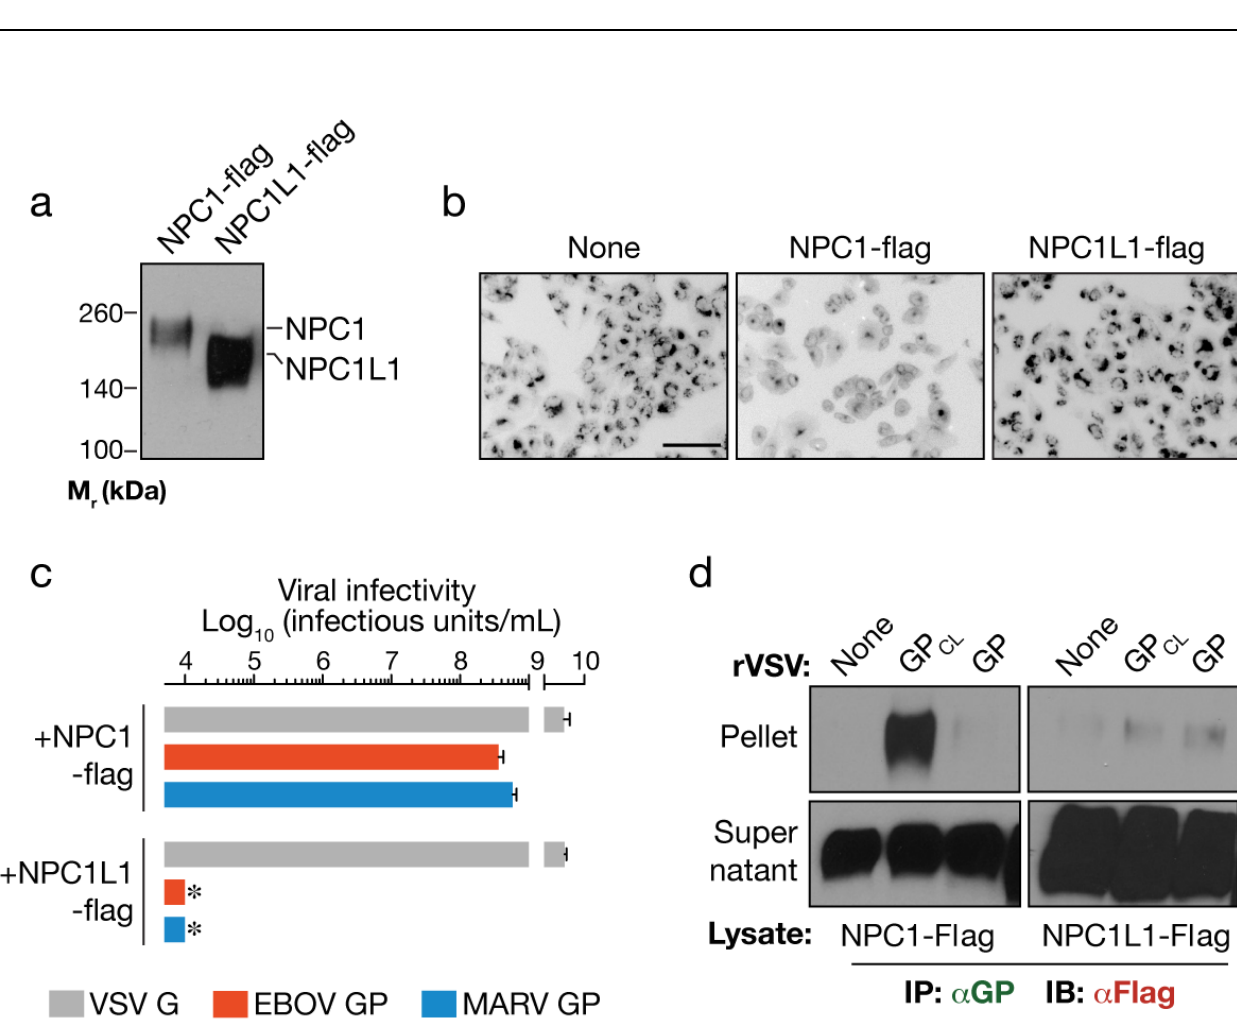
Figure 1. Human Niemann-Pick C1-like1 (NPC1L1) lacks filovirus receptor activity. (a) NPC1-null Chinese hamster ovary (CHO) CT43 cells were engineered to express human NPC1-flag or NPC1L1-flag. Protein expression was detected by immunoblotting with an anti-flag antibody. M , relative molecular weight in kilodaltons (kDa). (b) Efflux of r lysosomal cholesterol mediated by NPC1-flag and NPC1L1-flag in CT43 cells was determined by filipin staining and flu orescence microscopy. Scale bar, 20 μm. (c) Infection of CT43 cells expressing NPC1-flag or NPC1L1-flag by vesicular stomatitis virus (VSV) pseudotypes bearing VSV G or filovirus glycoproteins. Asterisks indicate data points at or below the limit of detection. (d) Co-immunoprecipitation (co-IP) of NPC1 and NPC1L1 by Ebola virus (EBOV) GP. Magnetic beads coated with GP-specific monoclonal antibody KZ52 were incubated with detergent extracts containing no virus (None), uncleaved VSV- GP, or cleaved VSV-GP . Control or glycoprotein-decorated beads were mixed with cell CL extracts containing NPC1-flag or NPC1L1-flag. Beads were then retrieved and flag-tagged proteins in the immune pellets and supernatants were detected by immunoblotting